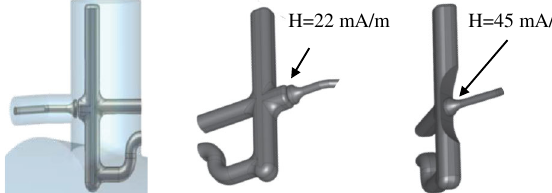
FIG. 4. TESLA cavity. End groups are marked with dashed lines.